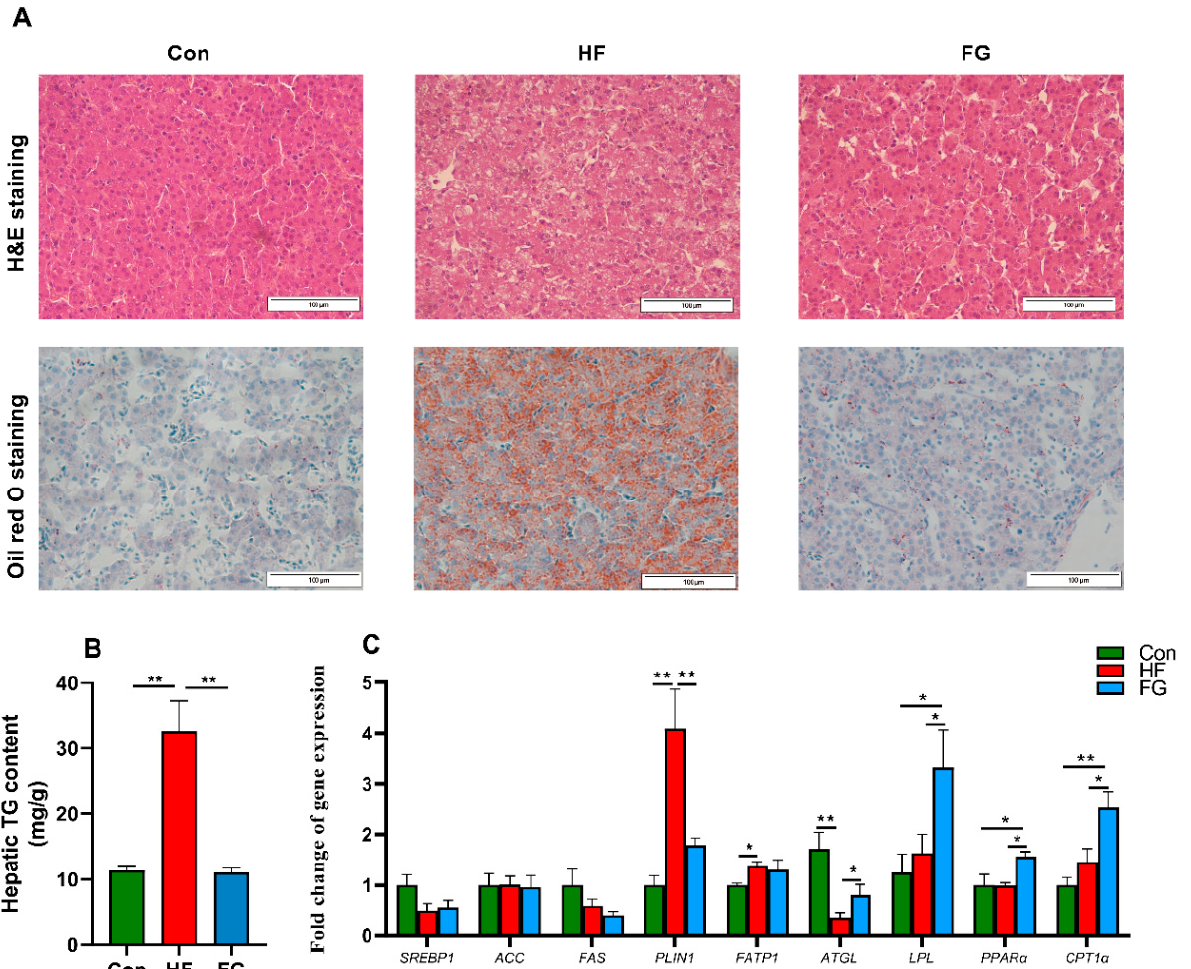
Figure 2. Effects of dietary fat level and GABA supplementation on histological changes ( A ), hepatic TG content ( B ), and the expression of lipid metabolism-related genes ( C ). Data are presented as mean ± SEM, * p < 0.05, ** p < 0.01. TG, triglyceride; SREBP1 , sterol regulatory element-binding